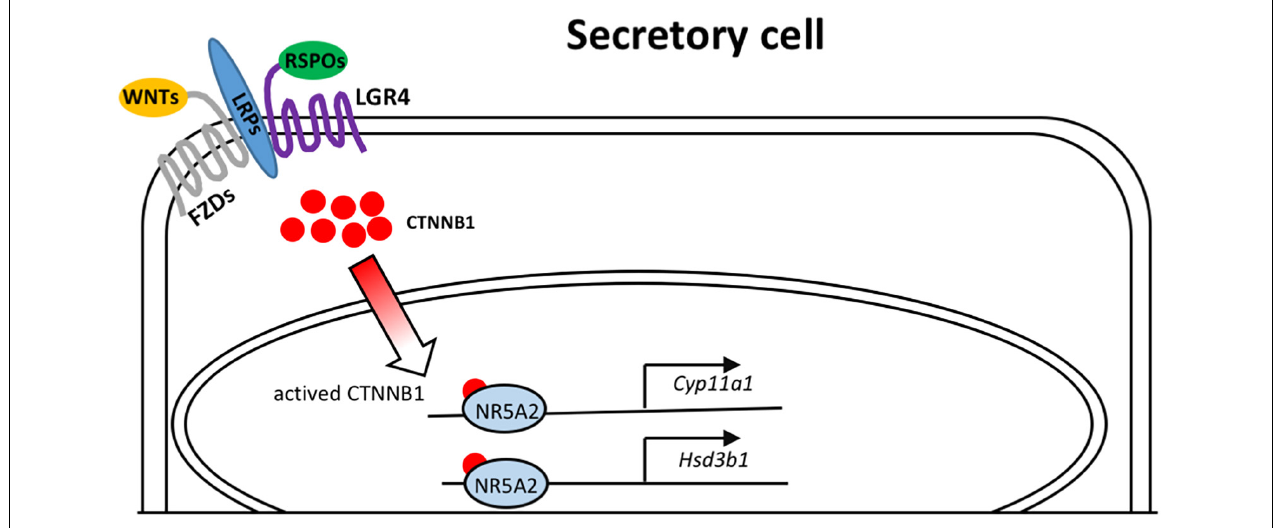
FIGURE 6 | Model depicting the molecular mechanisms of LGR4 mediated WNT signaling that activates the transcription factor NR5A2 to bind on the promoters of the steroidogenic genes, Cyp11a1 and Hsd3b1